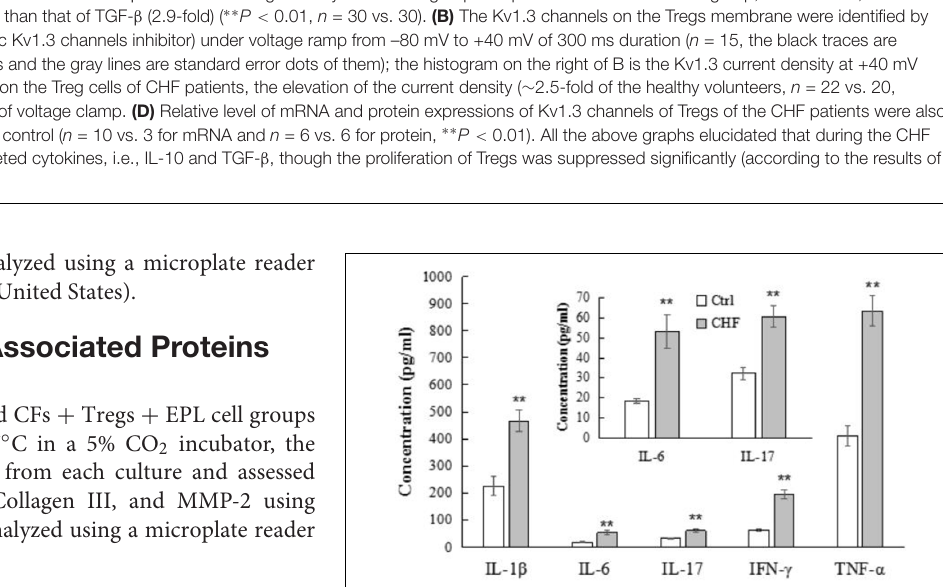
FIGURE 3 | The histograms comparison of plasma levels of the inflammatory cytokines including IL-1 β , IL-6, IL-17, IFN- γ , and TNF- α of control vs. CHF rats (determined by ELISA). All the inflammatory cytokines levels in CHF group were significantly higher than that in the control group ( n = 12, ∗∗ P < 0.01). The inner histogram comparison graph of IL-6 and IL-17 levels is zoomed in from the bigger one since their levels were relatively lower than other three